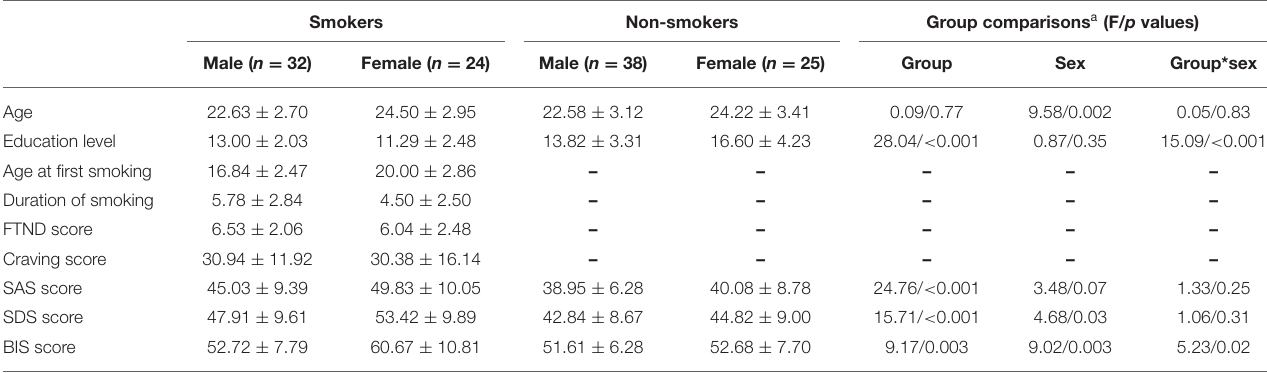
TABLE 1 | Demographic information of the subjects in each group and between-group